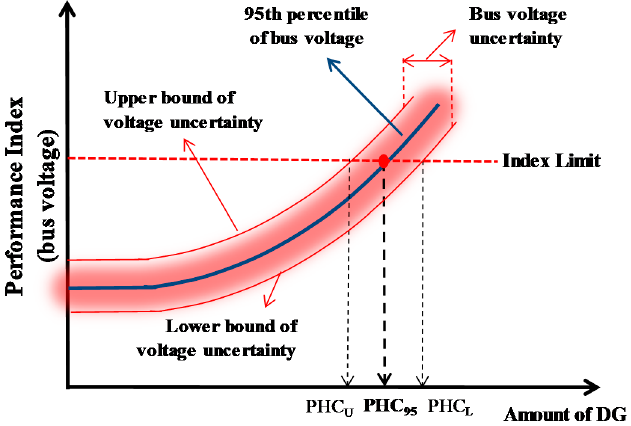
Figure 3. The concept of uncertainty handling in PHC analysis.